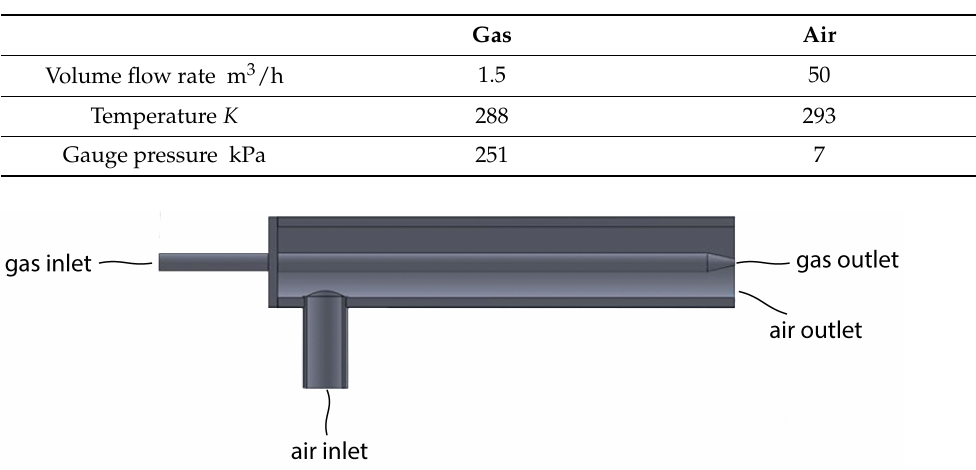
Table 2. Operation parameters for the analyzed blast furnace with one typical gas burner.